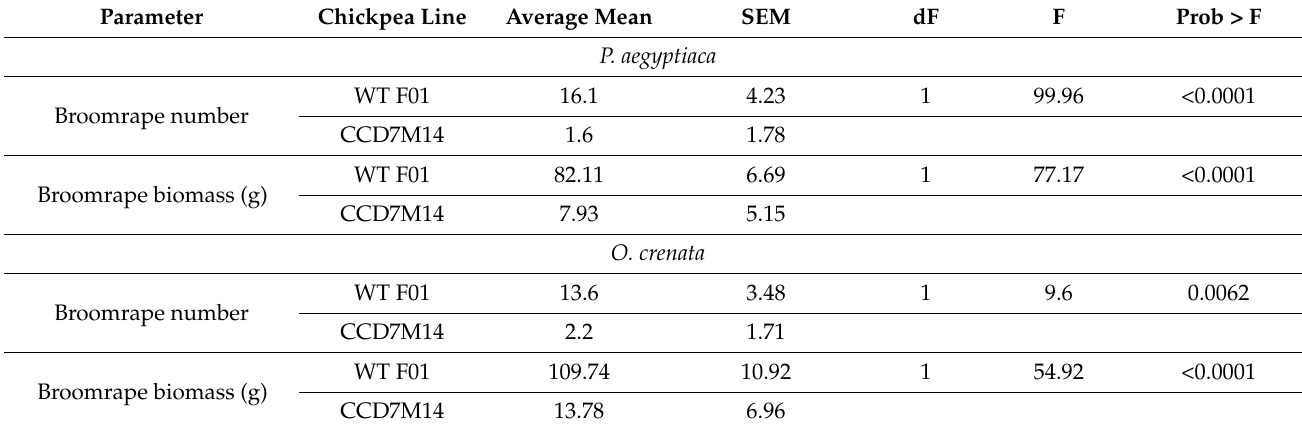
Figure 1. Aboveground broomrape shoots in pots planted with WT F01 or the CCD7M14 mutant. The experiments were arranged in a completely randomized design with 10 replications (pots) per treatment. Lines show the percentages of infected plants, bars indicate the average numbers of aboveground shoots attached to the infected plants. ( a ) Infestation with P. aegyptiaca . ( b ) Infestation with O. crenata. Vertical lines indicate standard error of the mean (SEM). Lowercase letters indicate least-significant differences (LSD), based on the Tukey–Kramer honestly significant difference test ( α = 0.05) between the chickpea lines. Table 1. Statistical analysis of the chickpea resistance experiments. The results were subjected to ANOVA. The experiments were conducted with ten replications. SEM—standard error of the mean, dF—Degrees of Freedom; F—F ratio, Prob > F— F